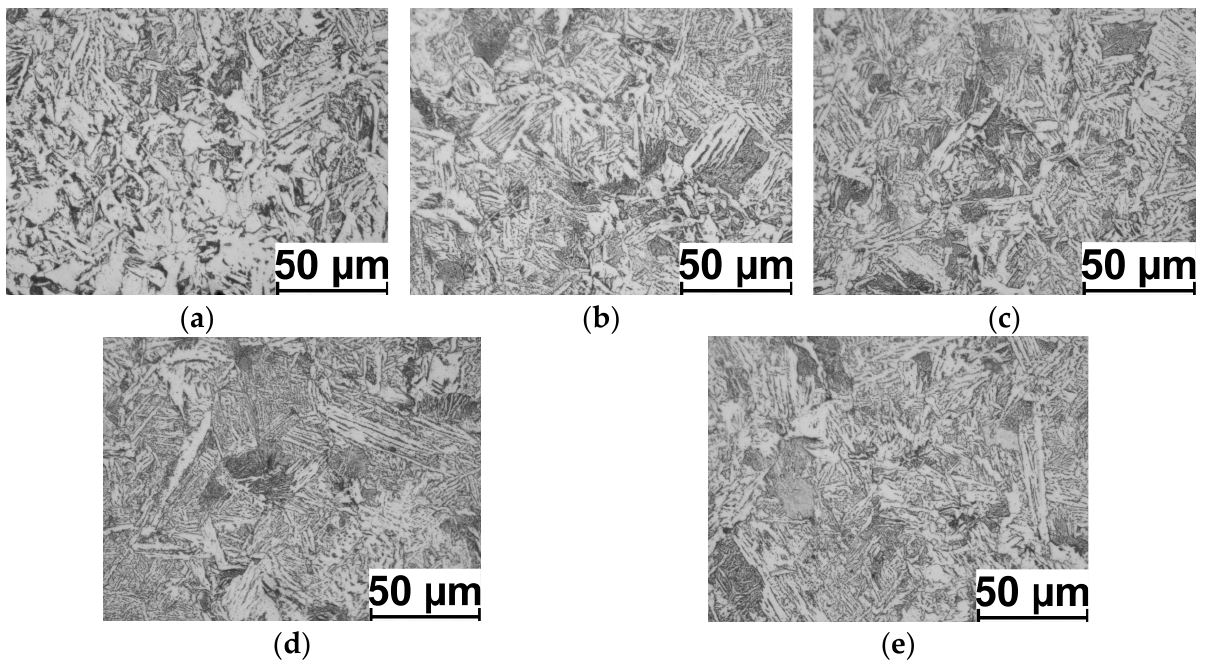
Figure 13. Example microstructures of 20MnB4 steel after physical modelling of a wire rod rolling process for test variant V1 (marking of points in accordance with Figure 5): ( a ) point P. 1, ( b ) point P.